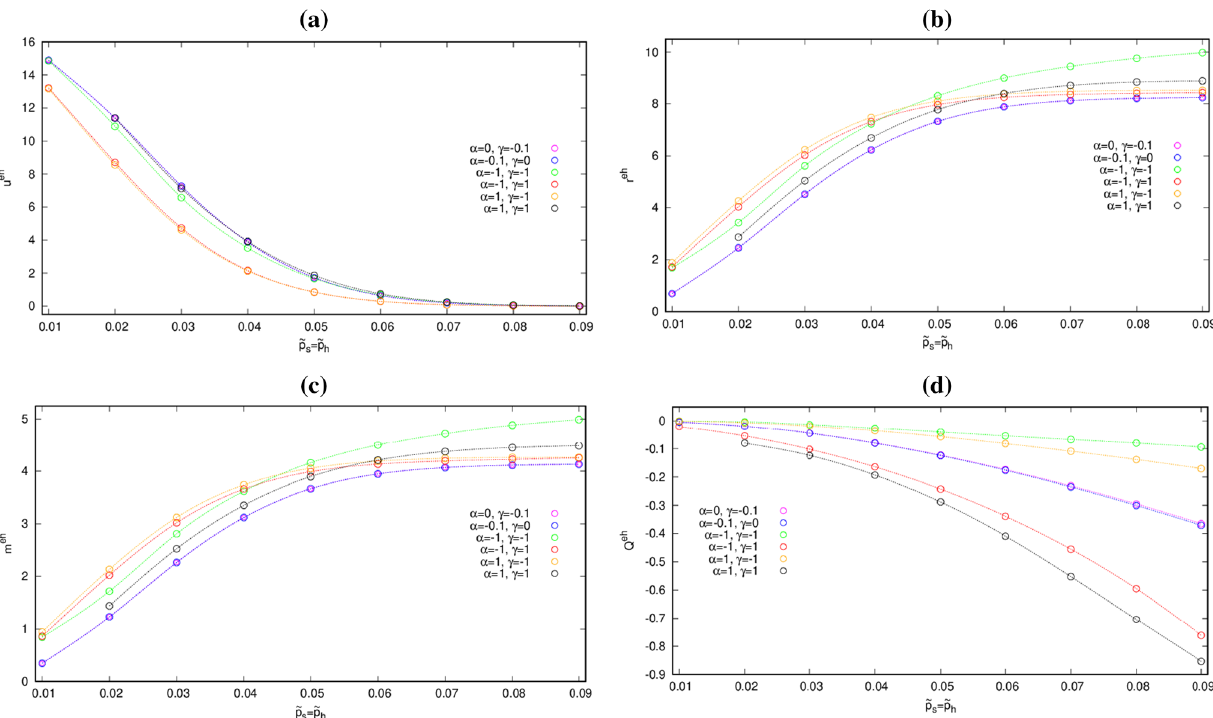
Fig. 8 The a u -locations of the event horizons, u eh , b radii, r eh , c masses, m eh formed during the gravitational collapse as functions of the field amplitudes, ˜ p s and ˜ p h , for several combinations of values of the parameters α and